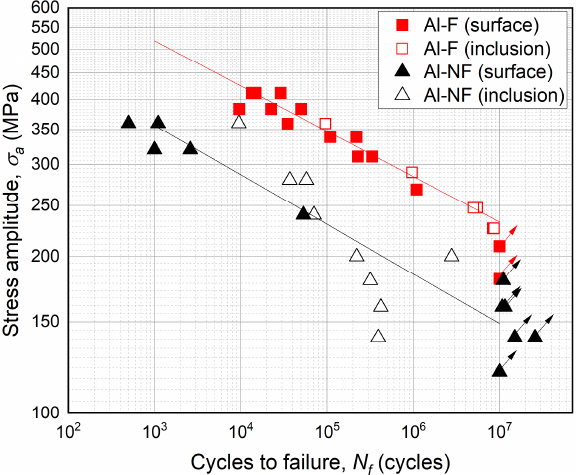
Figure 7 . S–N curves of aluminum alloys obtained from the rotary bending fatigue